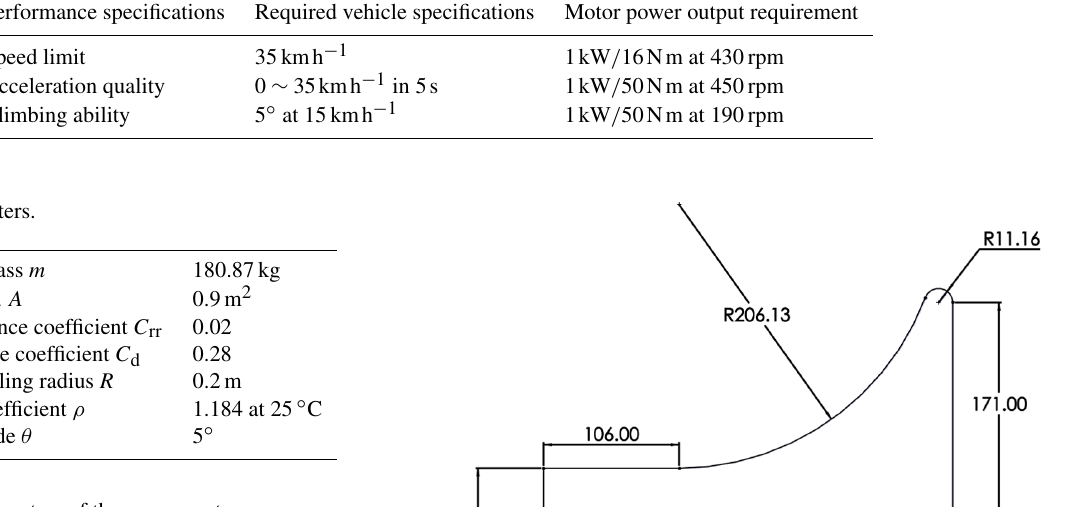
Table 6. Required parameters of the power system.